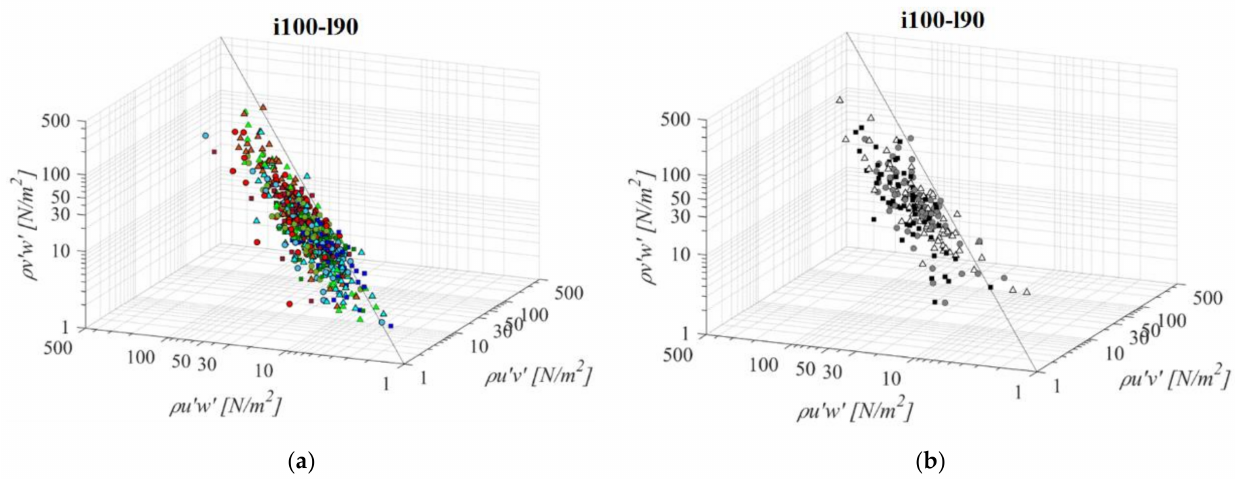
Figure 10. 3D scatterplot of concurrent RSS components for the i100l90 fishway configuration: ( a ) pool-orifice type fishway and ( b ) vertical slot